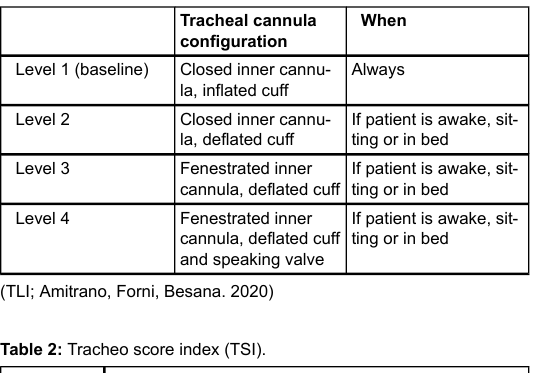
Table 1: Tracheo level index (TLI)